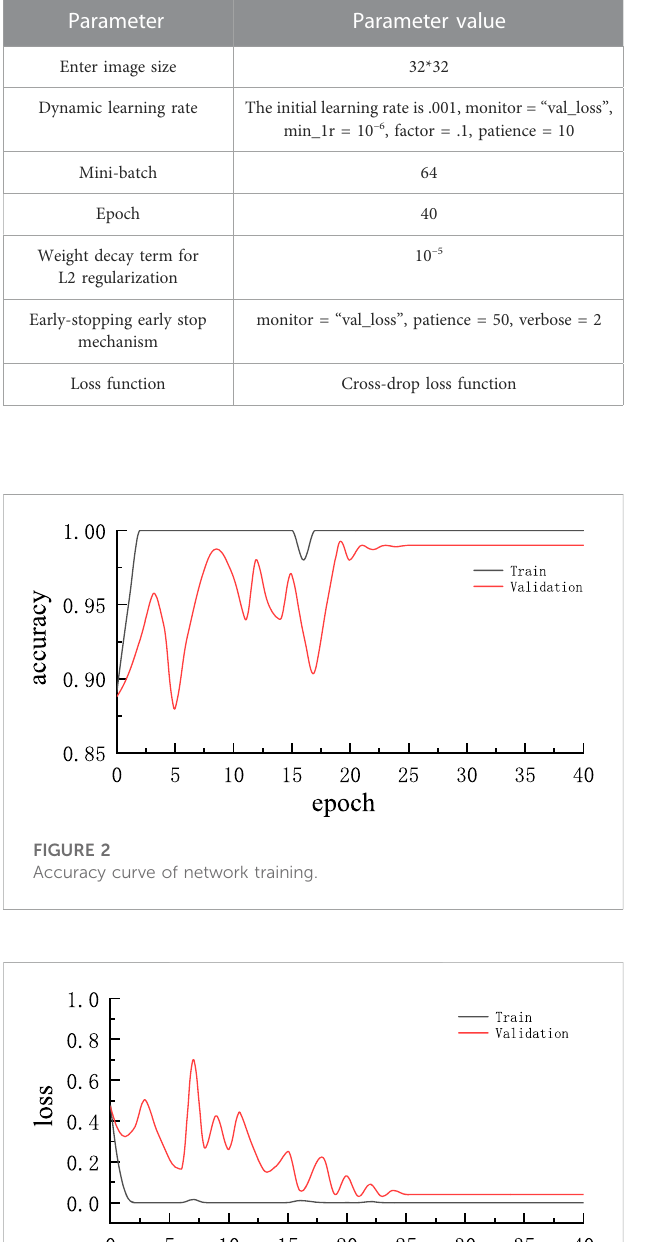
FIGURE 3 Loss change curve of network